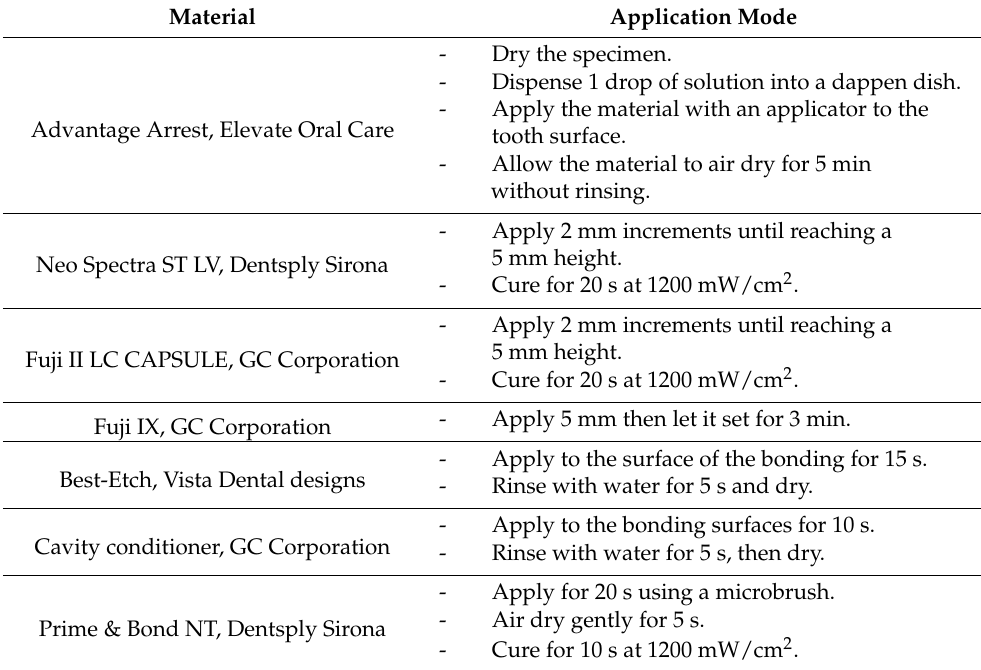
Table 1. Application mode of the restorative